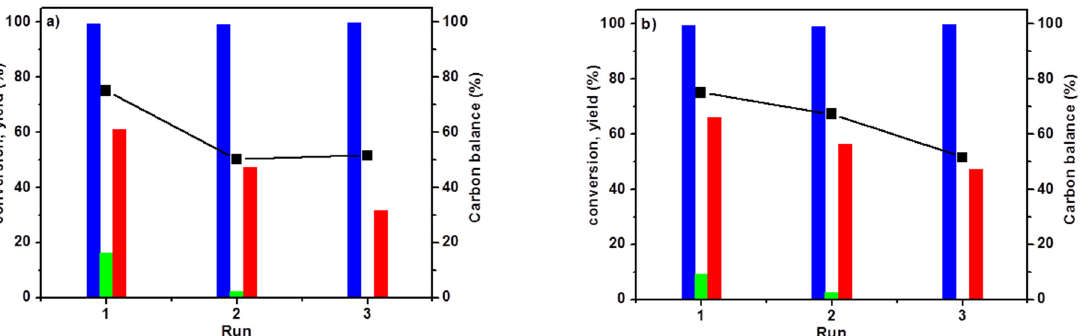
Figure 8 . Catalyst recyclability study: ( a ) Au/AC_PVA and ( b ) Au/AC_PVP: ( ■ ) HDO conversion, ( ■ ) AA yield, ( ■ ) HHA Yield, ( ■ ) Carbon balance. Reaction conditions: HDO 42 mmol L − 1 , 20 mL H 2 O, nHDO/nAu =250, 110 °C, 800 rpm, 15 bar air, 4 h, stabilizer/Au weight ratio of 1.2.